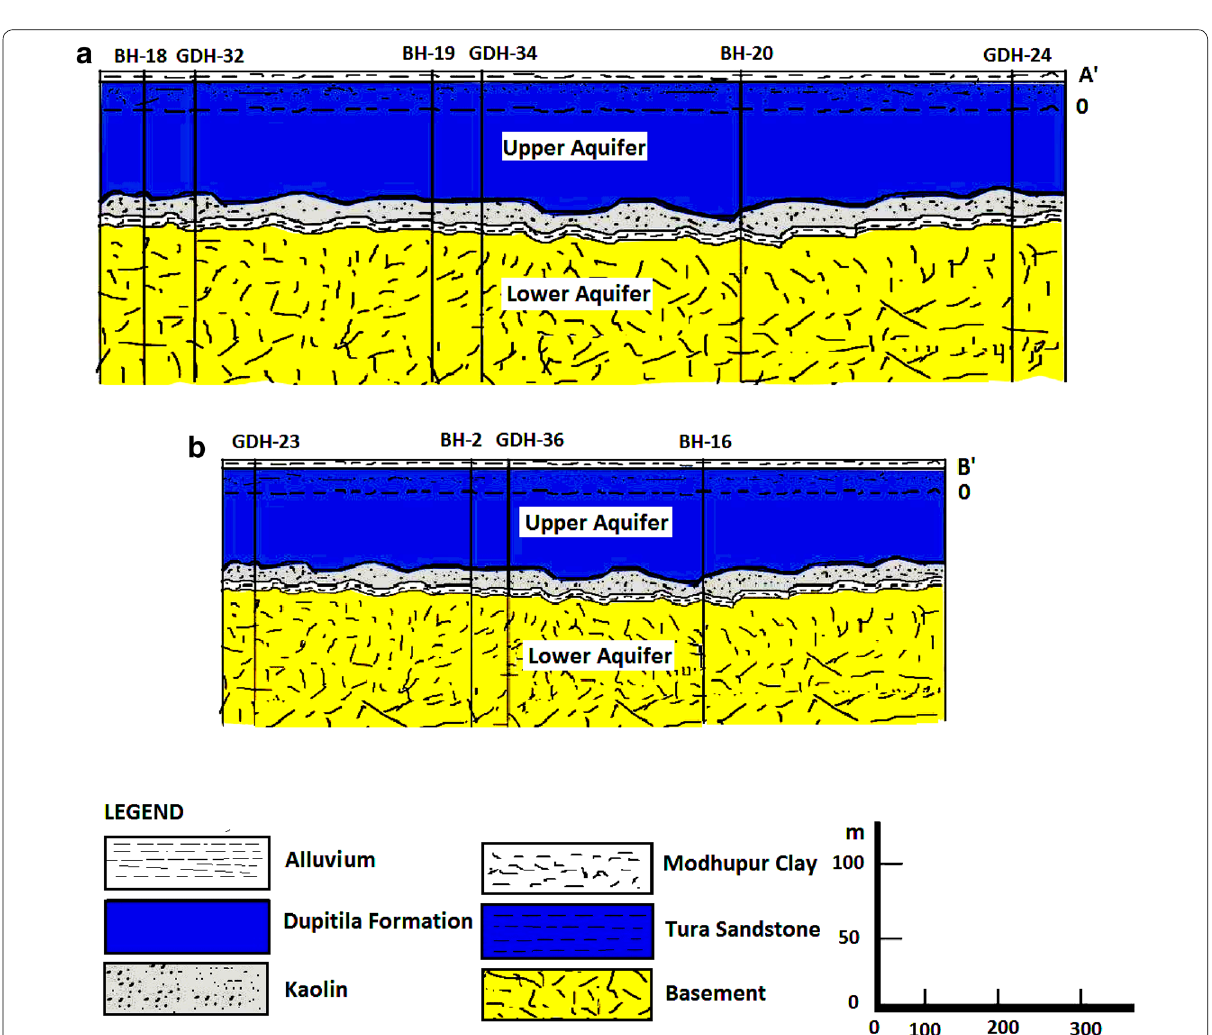
Fig. 4 Hydrogeological cross section of the Maddhapara Mine area [Modified after Bashar et al.